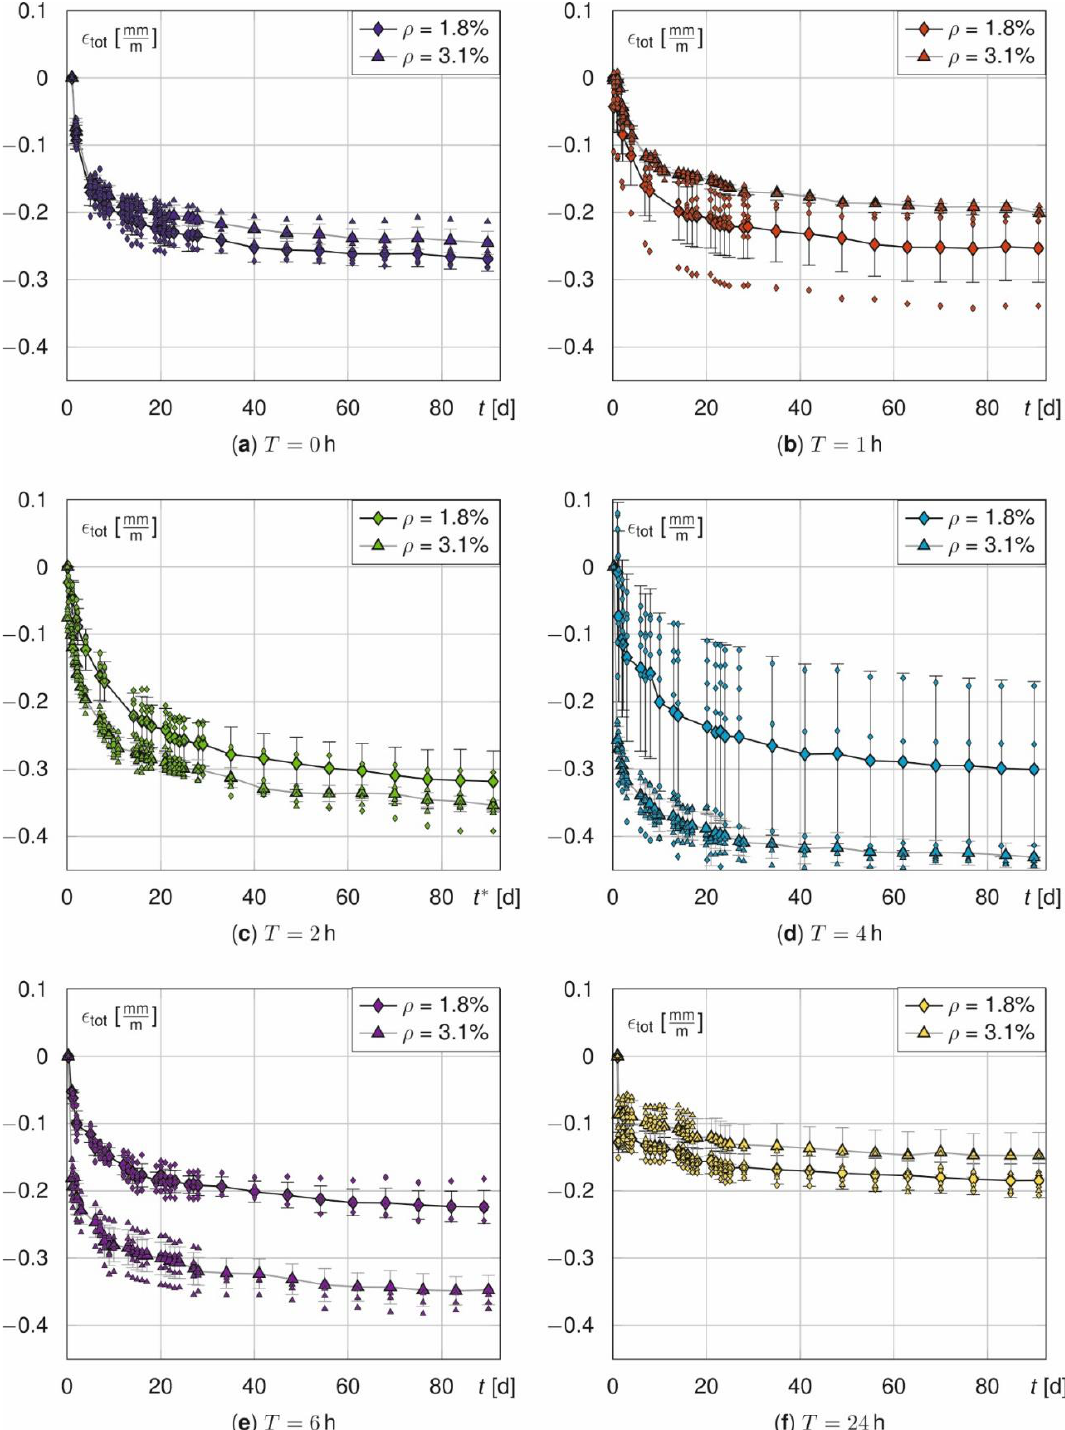
Figure 6. Total strain ε tot of the beams as a function of rebar ratio ρ for T = 0 h ( a ), T = 1 h ( b ), T = 2 h ( c ), T = 4 h ( d ), T = 6 h ( e ) and T = 24 h ( f ). Consideration of the initial temperature strain ε T As boundary conditions, the temperature ϑ in the specimen at time t = 0 h is set constant to the initial temperature ϑ 0 , according to Equation To determine the residual shrinkage strain after heat treatment ε cs * , the temperature strain ε T according to Equation (3) is subtracted from the total strain ε tot .